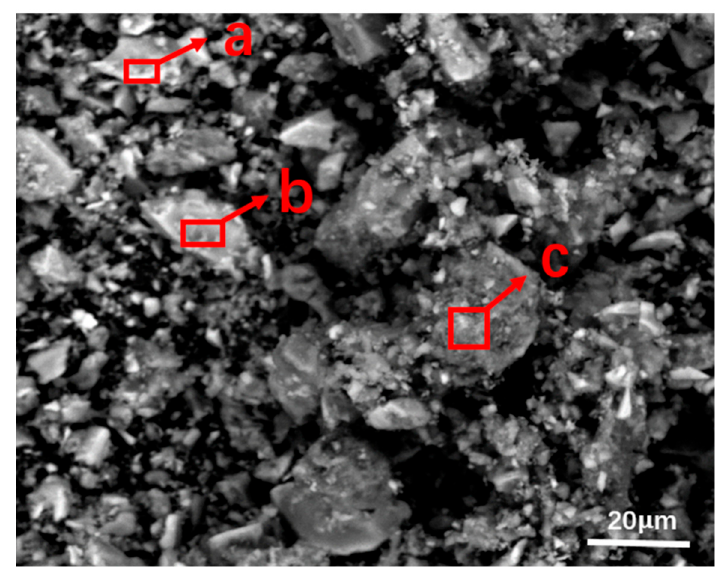
Figure 4. XRD pattern of the final product.